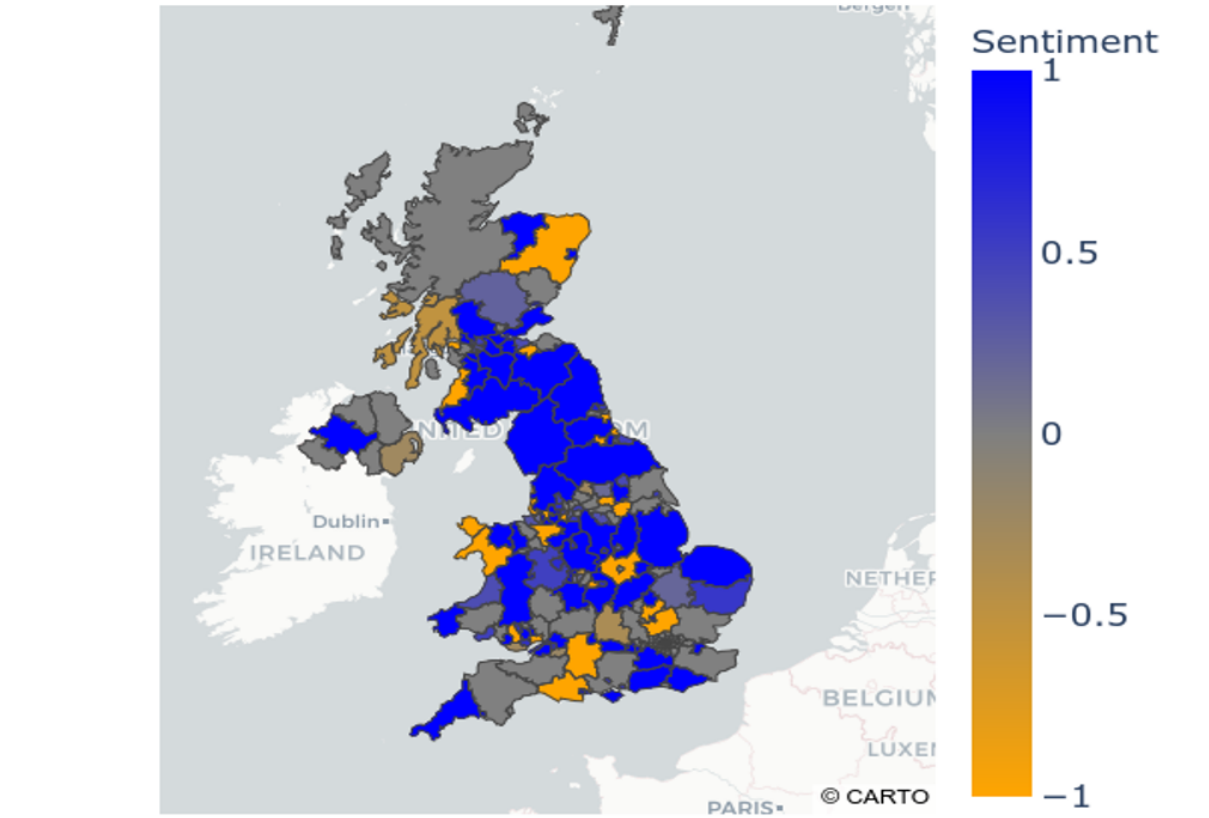
Figure 3. Spatial mapping of (averaged) UK public sentiment related to COVID-19 contact tracing apps on